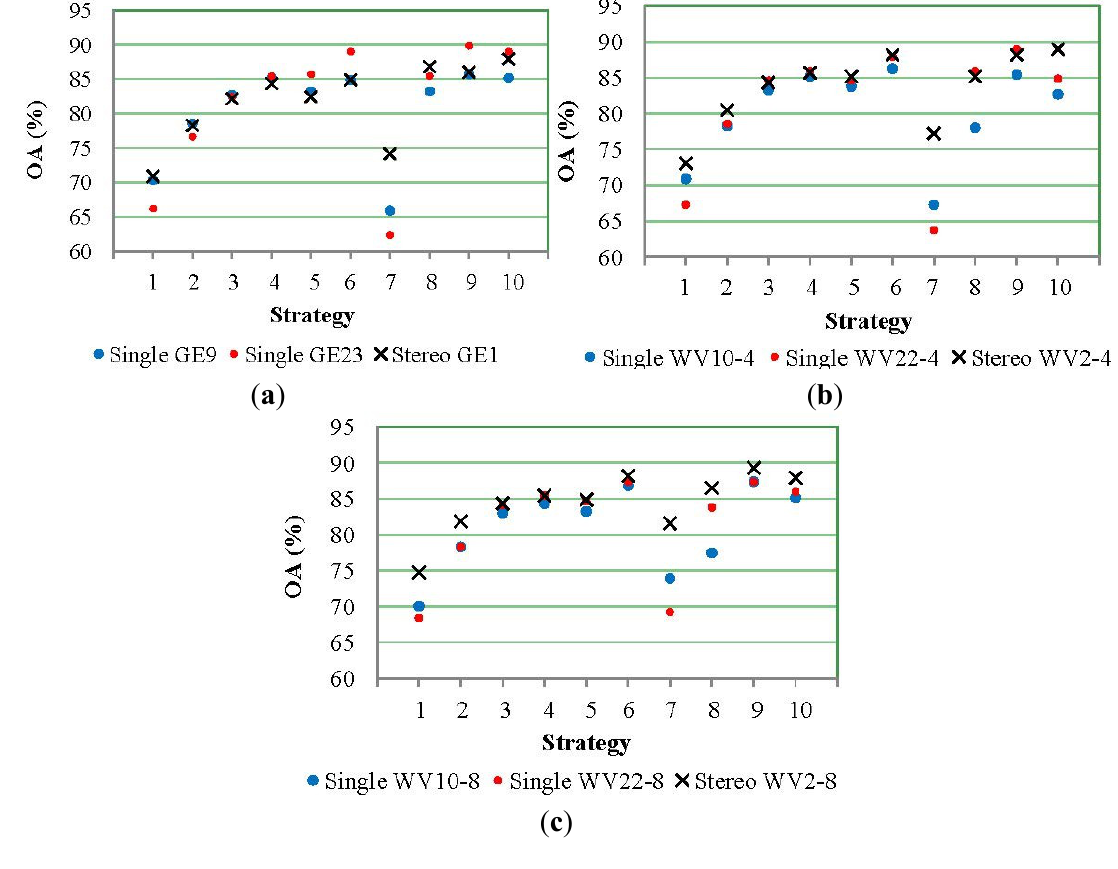
Figure 9. Overall accuracy values from classification assessment by using the NN classifier. ( a ) Tests based on GE1 imagery; ( b ) tests based on WV2 imagery only using the four classical bands; and ( c ) tests based on WV2 imagery using all the eight MS